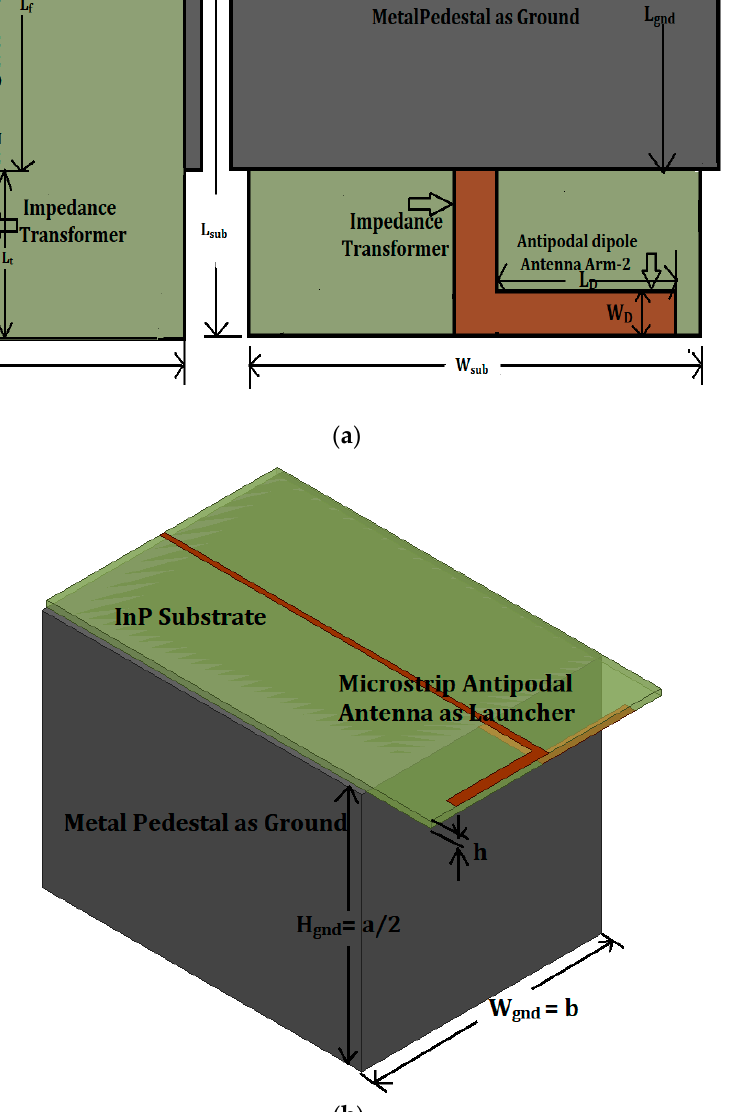
Figure 2. Microstrip antipodal dipole antenna as RF energy launcher for V-band transitions. ( a ) Front view, rear view, and side view; ( b ) microstrip line.